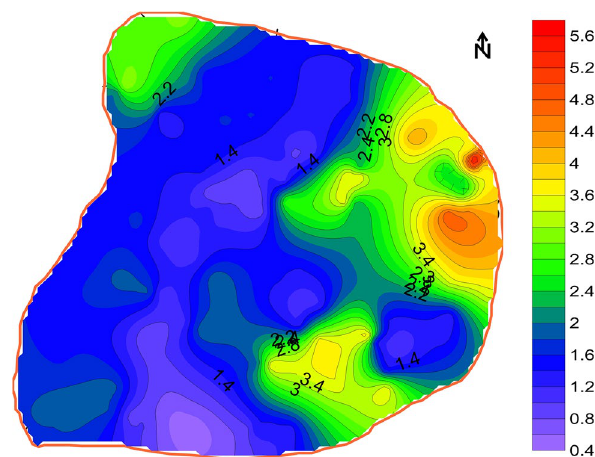
Fig. 3 Distribution of fluoride concentration in the groundwater of the study